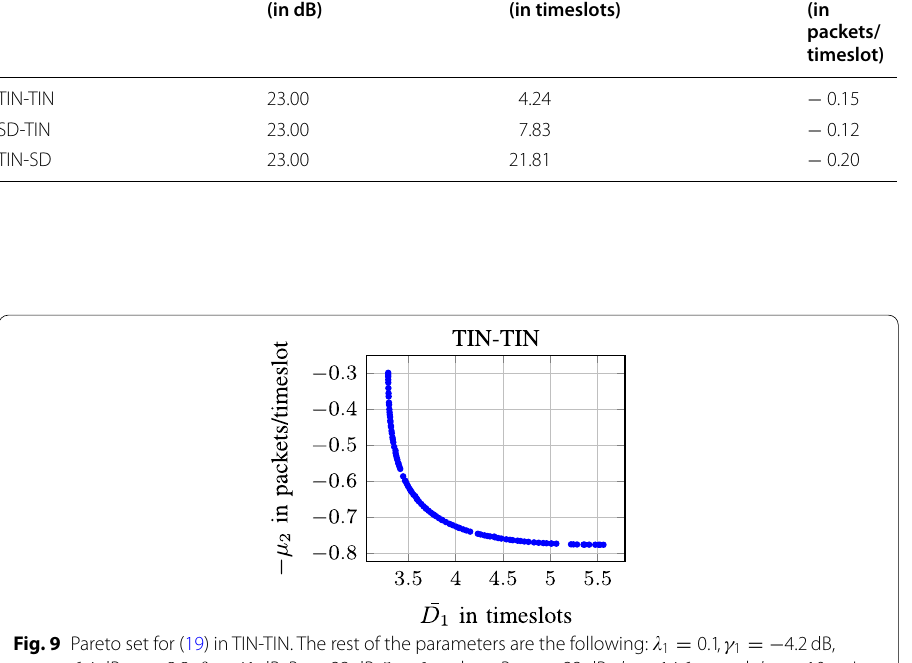
Table 4 Pareto optimal solution of the optimization problem in (20) for different decoding schemes Decoding